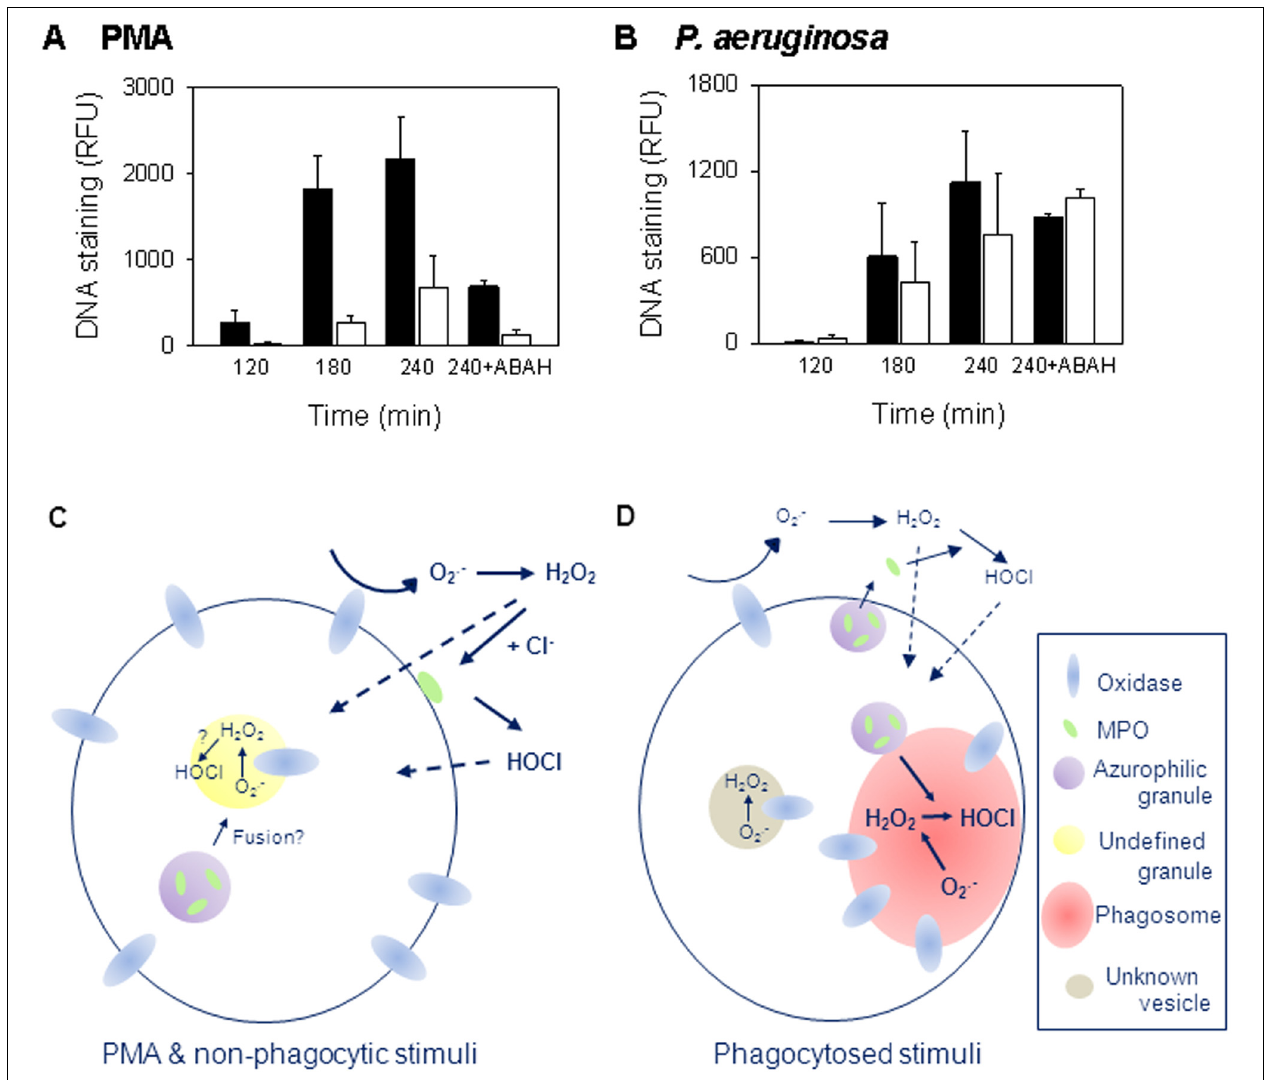
FIGURE 1 | Myeloperoxidase (MPO) is required for PMA but not bacterial induction of NETs. (A,B) The release of NETs from control (filled bars) and MPO-deficient (open bars) neutrophils measured over 4 h. MPO-deficient neutrophils formed NETs less efficiently with PMA, but not with P. aeruginosa , than neutrophils from control donors.To inhibit MPO, samples were incubated in the presence of 100 μ M of the MPO inhibitor 4-aminobenzoic acid hydrazide (ABAH). Results are means ± SEM of two to